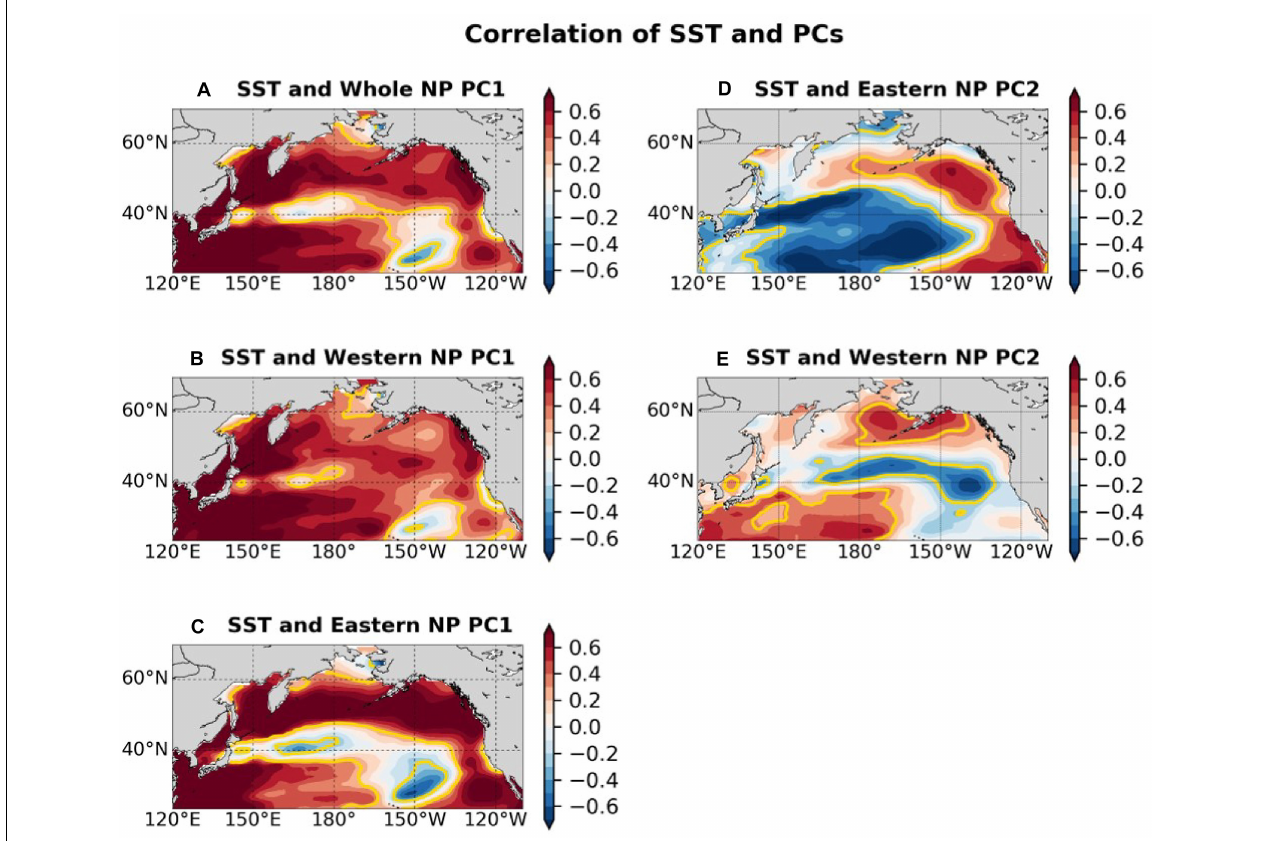
FIGURE 7 | Correlation map between SST and (A) whole NP PC1, (B) western NP PC1, (C) eastern NP PC1, (D) eastern NP PC2, (E) western NP PC2. The color shade indicates correlation value and the yellow contours indicate that areas have significant correlation at the 95% confidence level. Before calculating correlations 5-year running mean are applied to PCs and